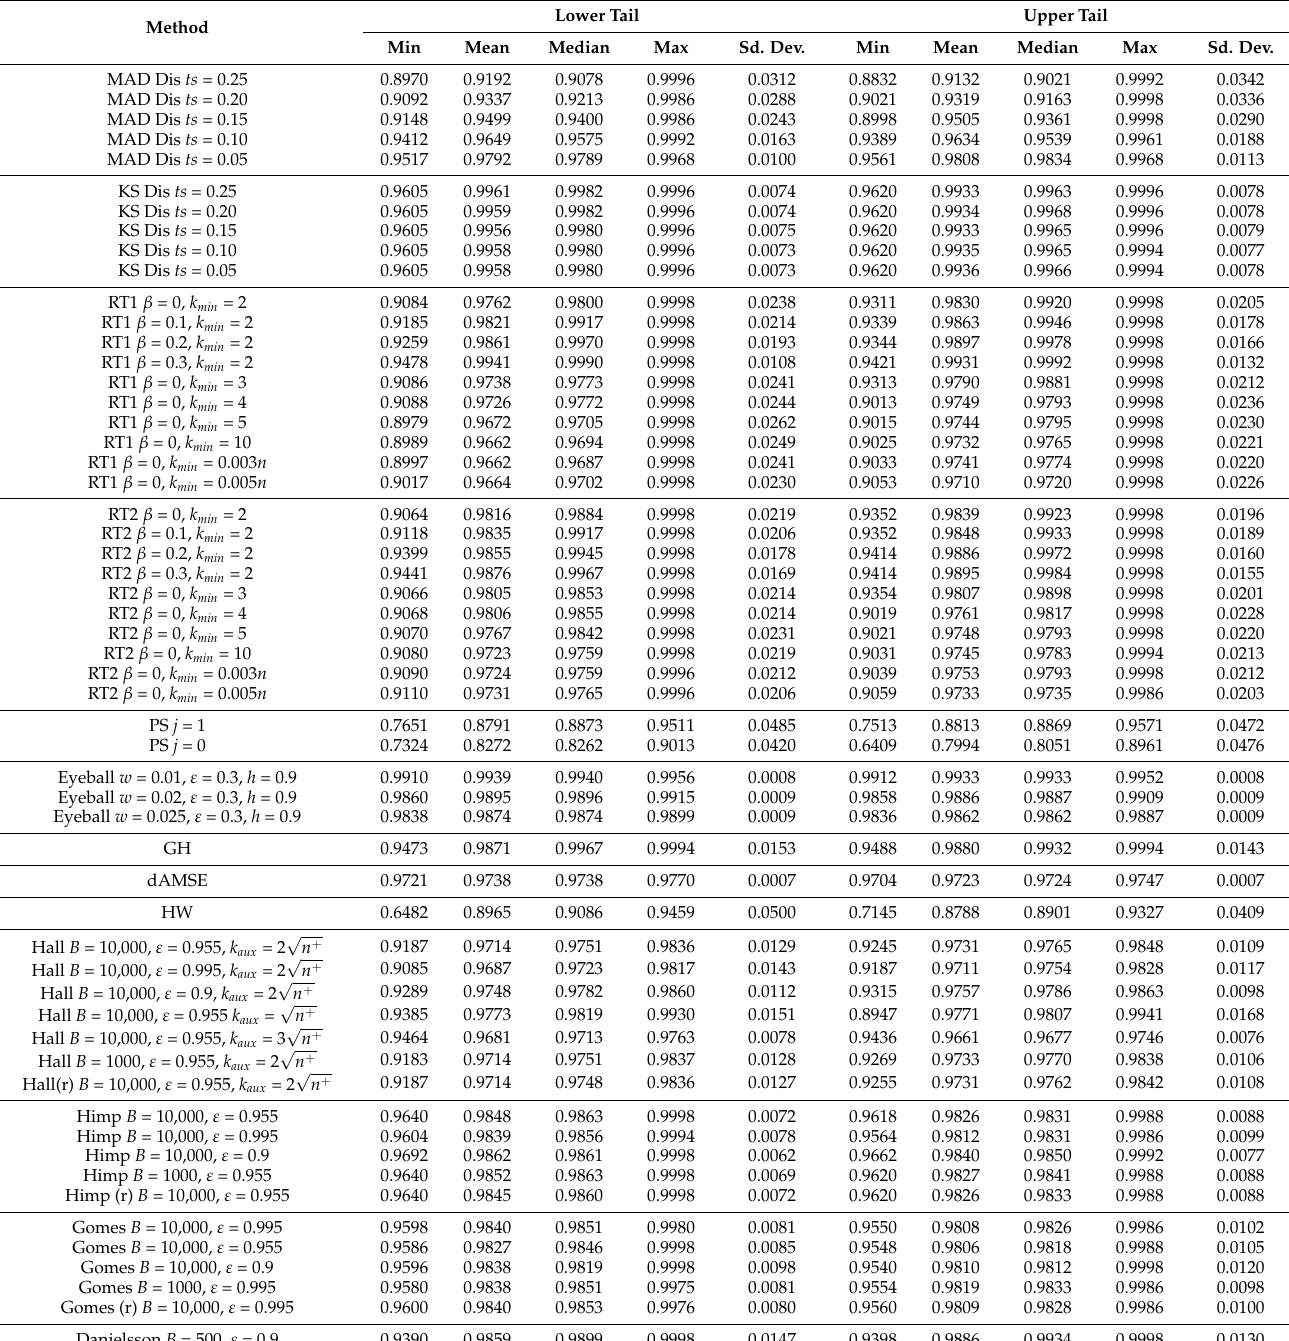
Table 2. Estimates of the threshold under different methods in the entire research